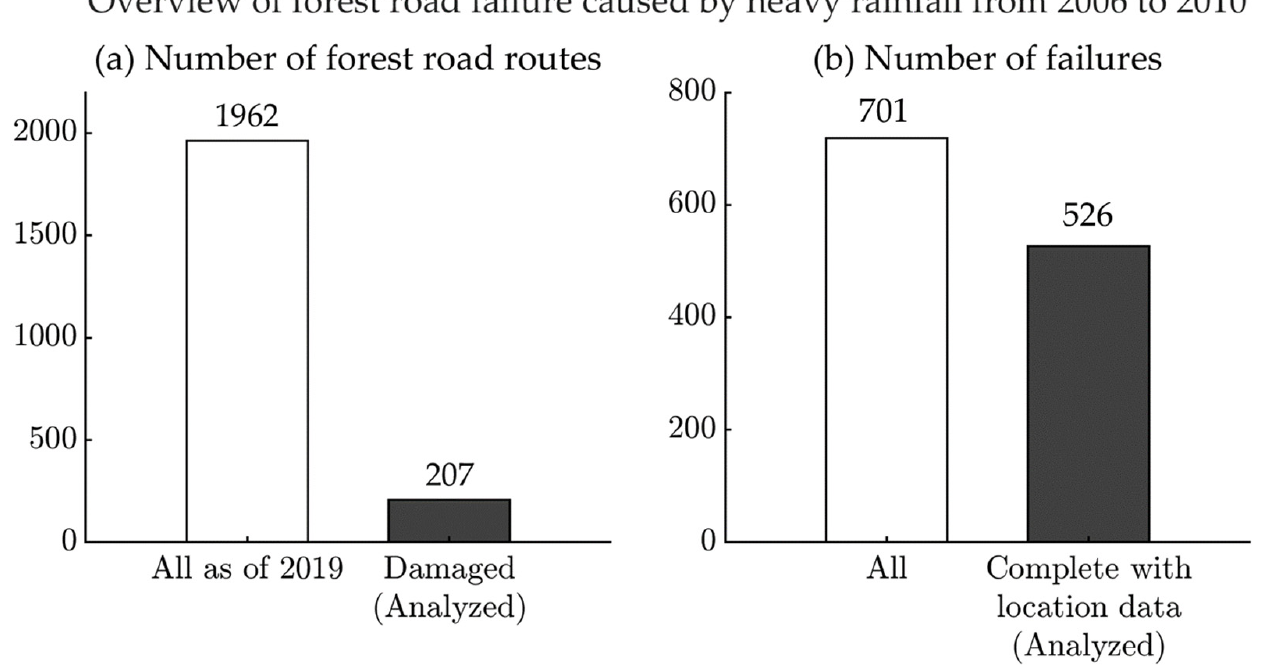
Figure 3. Number of forest road routes and failures analyzed. ( a ) Two hundred-seven routes where the failure occurred were included in the analysis. ( b ) Failures for which location information on both the failure and the forest road route has been developed are included in the analysis.